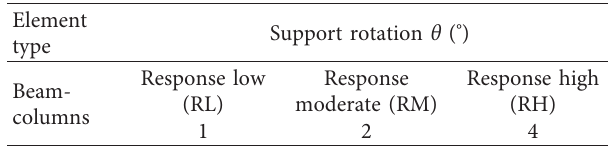
Table 5: Response limits for reinforced concrete.